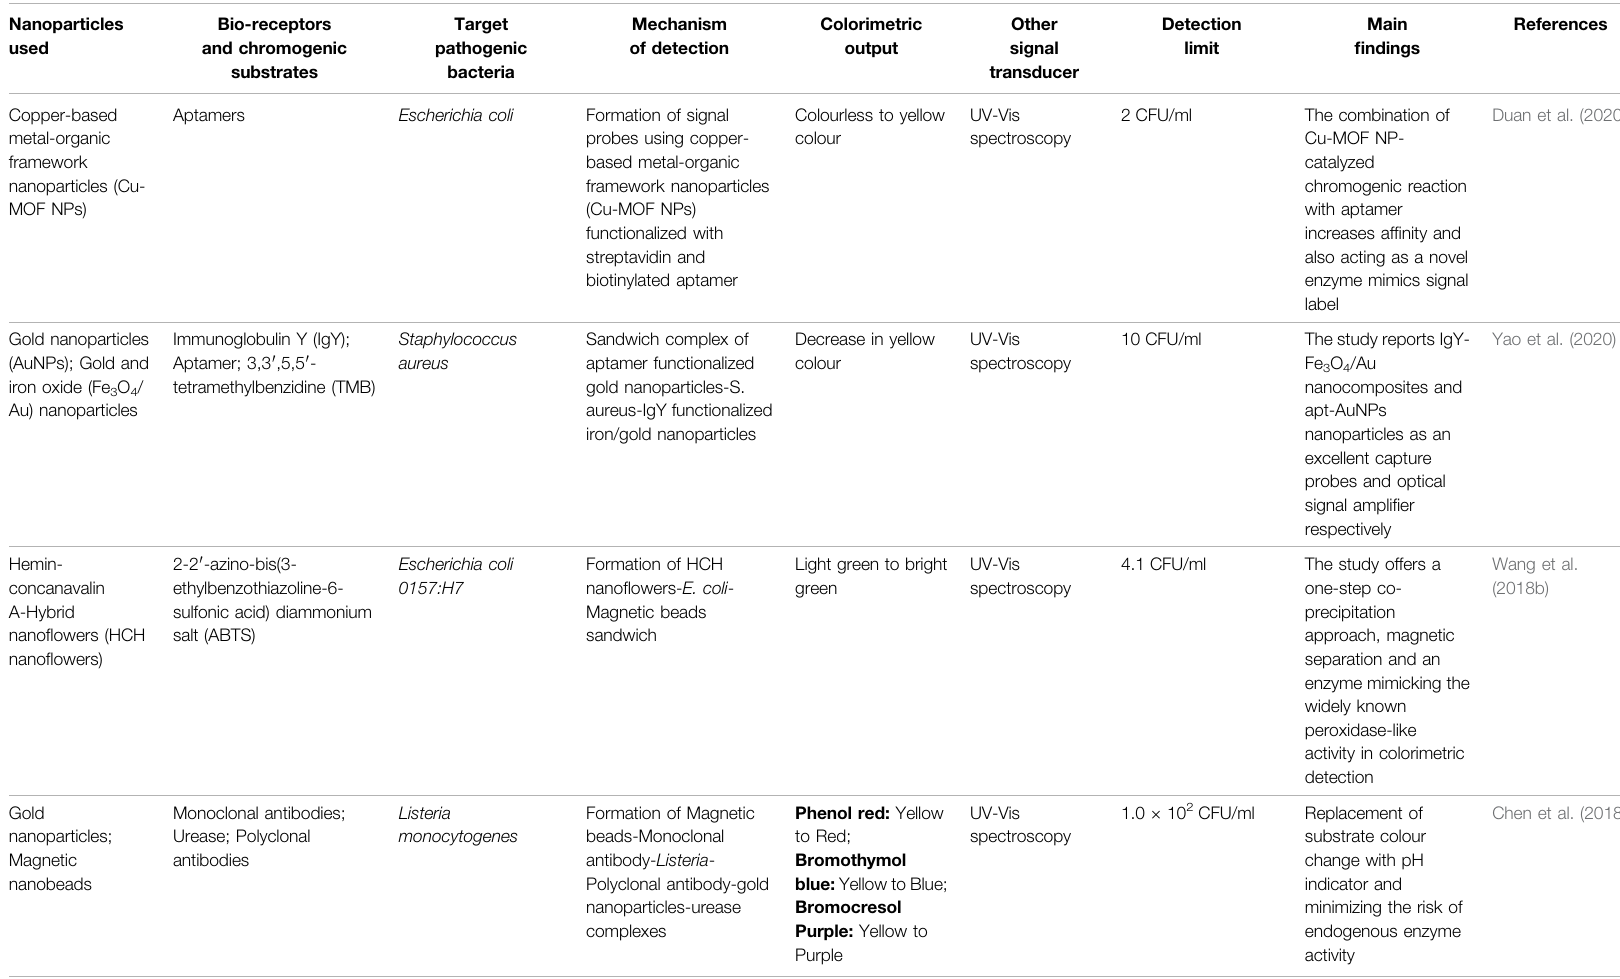
TABLE 2 | ( Continued ) Summary of studies that have applied bio-receptors and chromogenic substrates for the detection of pathogenic